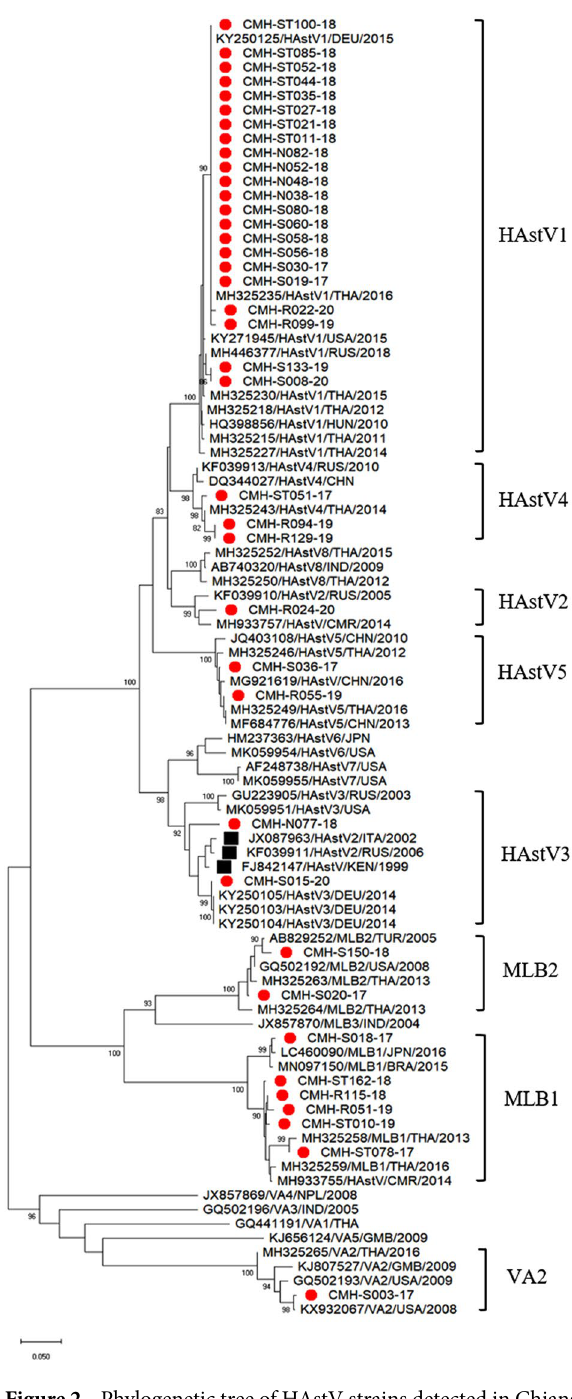
Figure 2. Phylogenetic tree of HAstV strains detected in Chiang Mai, Thailand during the period of 2017–2020. The scale bar represents nucleotide substitution per site. The HAstV strains detected in this study are labeled by red dot, HAstV recombinant reference strains (ORF1b: genotype 3/ORF2: genotype 2) are labeled by black square. The HAstV reference strains obtained from the GenBank database are indicated by accession